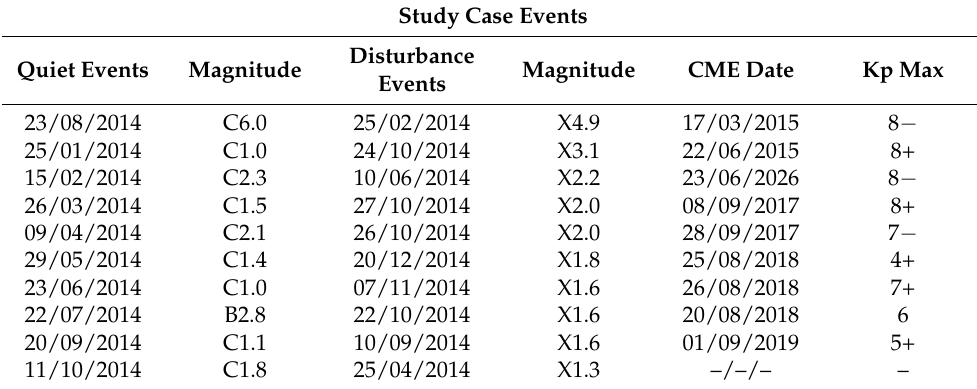
Table 1. Case studies table, containing all the dates for the quiet, disturbance, and CME event, along with their corresponding X-ray magnitudes and Kp